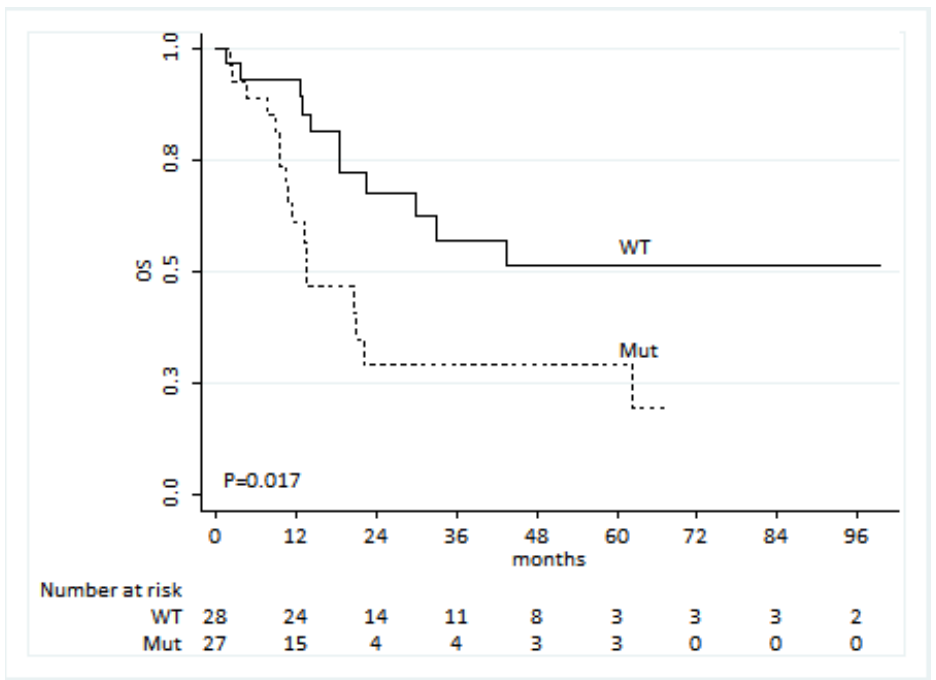
Figure 3. Overall survival (OS) of patients by EGFR mutation in cfDNA.